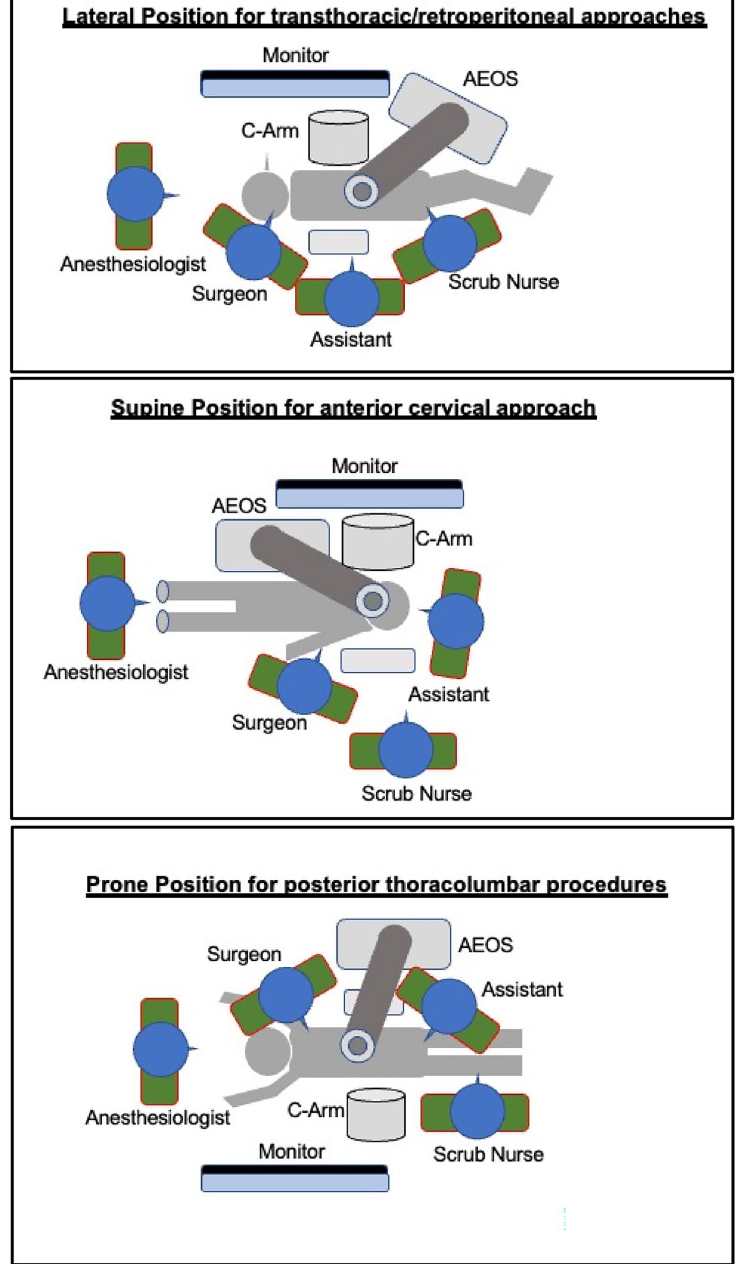
Figure 6. OR setup for cervical and thoracolumbar procedures based on patient and equipment